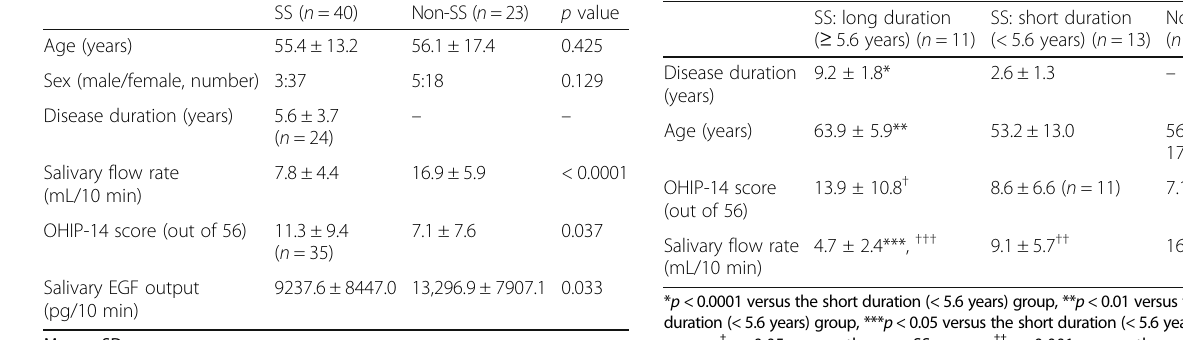
Table 2 Clinical characteristics of the SS and non-SS